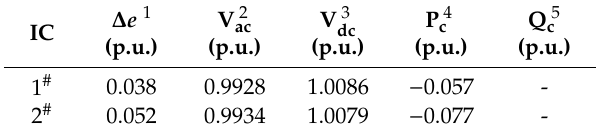
Table 8. Test results of the transferred power by interfacing converters (ICs) in the 12-bus IHMG system.